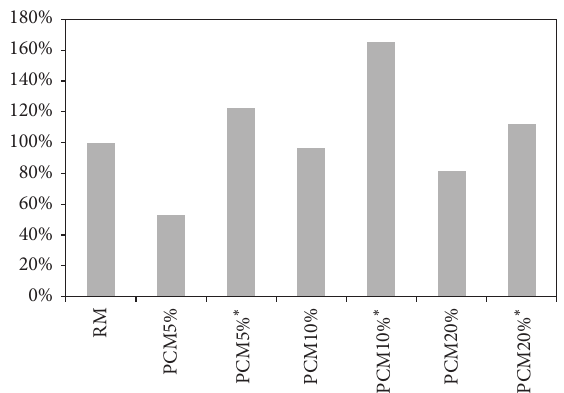
Figure 2: Compressive strength of mortars (data normalized with respect to reference mortar RM).